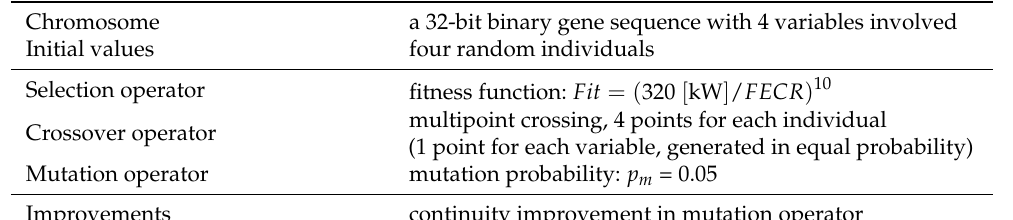
Table 5. The main difference between the standard and the modified GA is the continuity improvement conducted to the mutation operator. Table 5. Summary of modified genetic algorithm. Table 5. Summary of modified genetic algorithm.